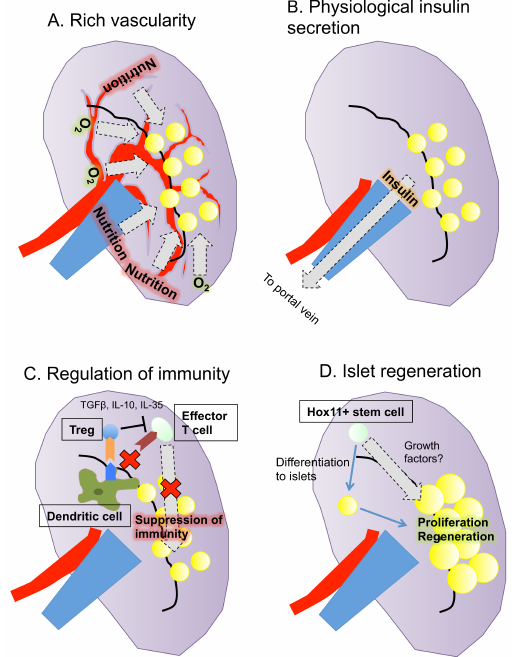
Figure 1. Summary of the characteristics of the spleen as a transplantation site for islets. The spleen has four advantages as a site of islet transplantation: ( A ) rich vascularity; ( B ) physiological insulin secretion; ( C ) regulation of immunity; and ( D ) potential for islet